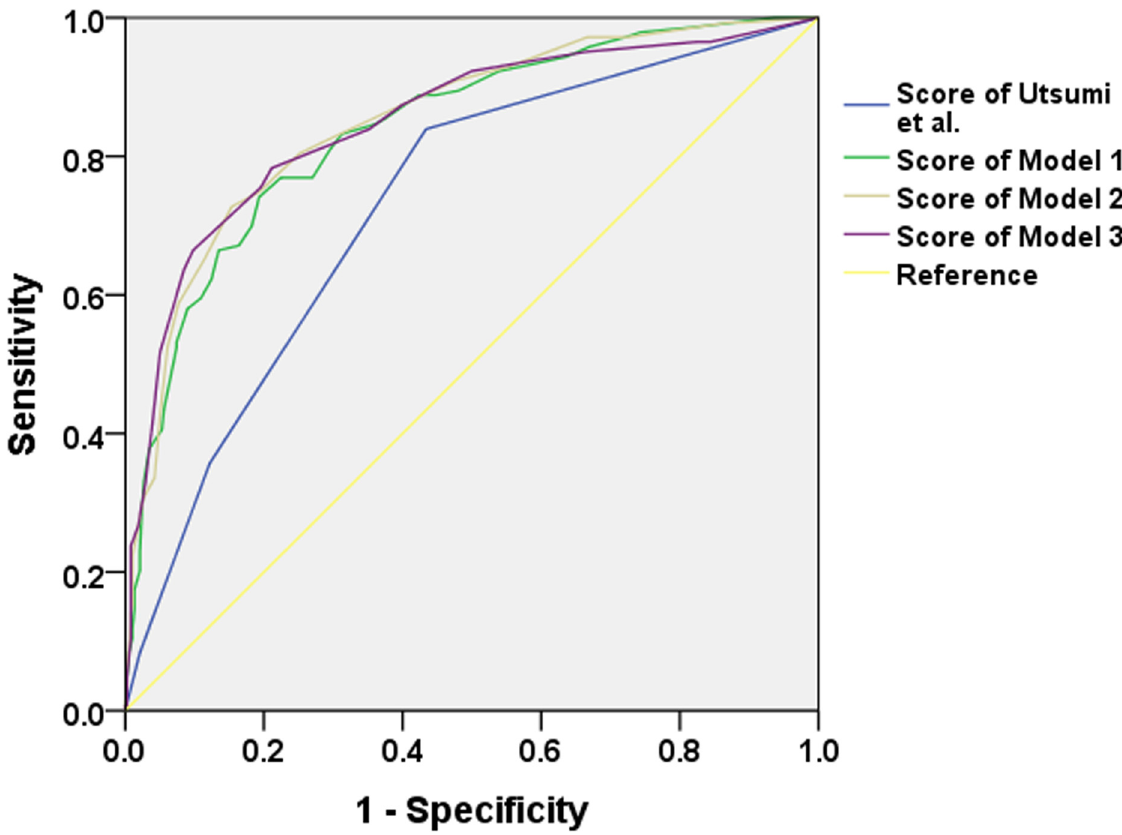
Fig 3. Receiver operating characteristic curves for prediction of AKI by the risk models of this study and previous risk score by Utsumi et al. Our risk models showed a significantly better performance in the comparison of AUC than the previous one.